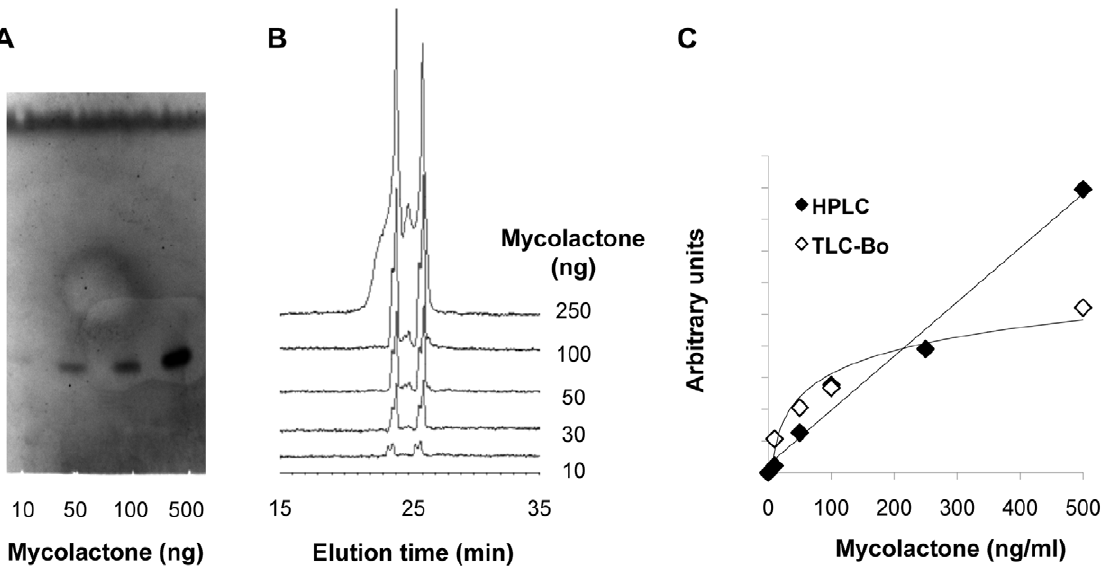
Figure 1. Comparison of the performances of the TLC-Fluo and HPLC approaches for mycolactone quantitative detection. A representative picture of the fluorescent signals and elution peaks obtained for mycolactone (10–500 ng) detection by TLC-Fluo (A) and HPLC (B) are shown, with the corresponding standard curves (C). Arbitrary units correspond to fluorescence intensity of the mycolactone band (TLC-Fluo) and area of the mycolactone elution peak (HPLC). Similar results were obtained in at least three independent experiments.